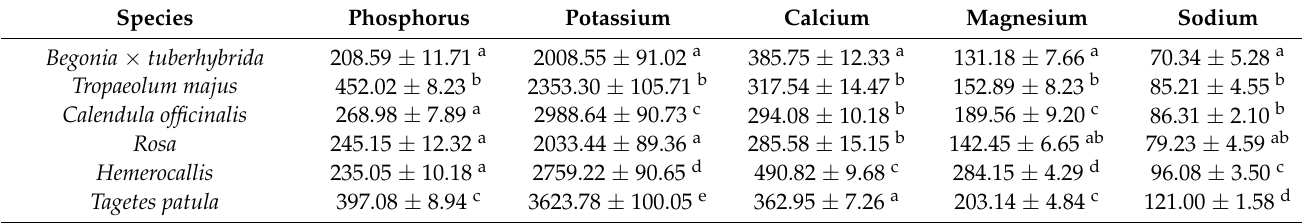
Table 4. Content of macroelements in 6 species of edible flowers.